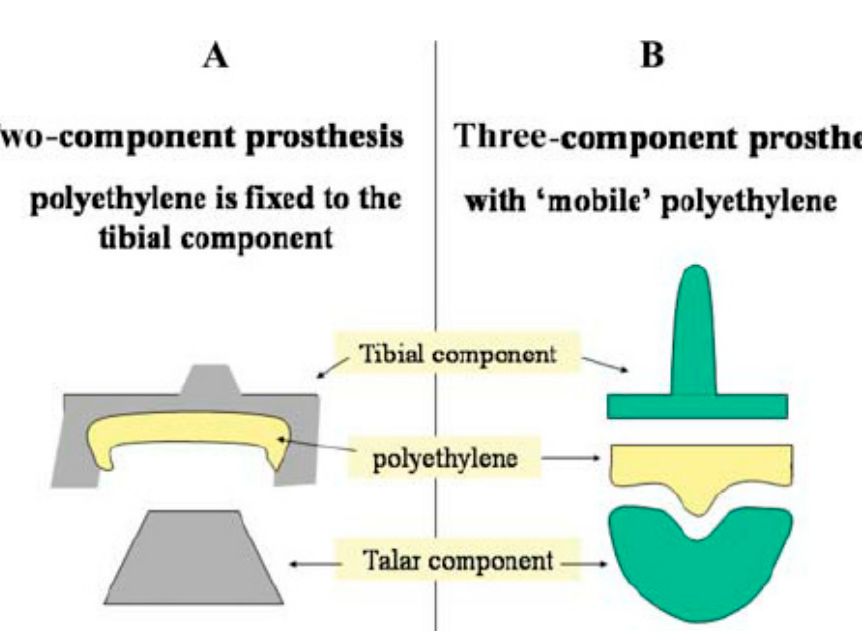
Figure 2. Difference between fixed-bearing prosthesis and a mobile-bearing prosthesis, where the polyethylene component is either fixed to the tibial component or free to move [11].